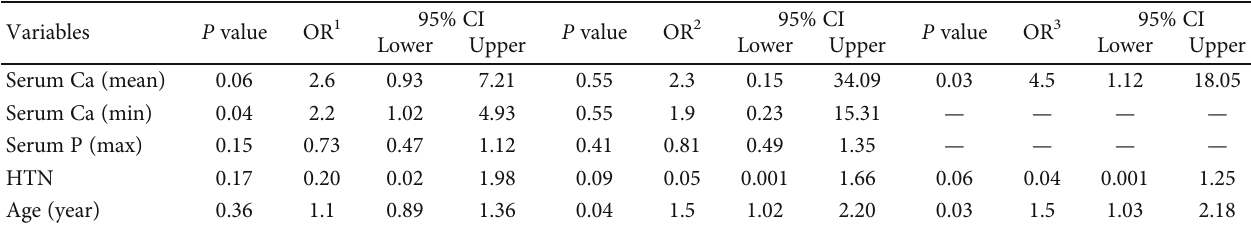
Table 6: Relationship of each of the most important study variables with the pruritus score based on logistic regression models. Variables P value